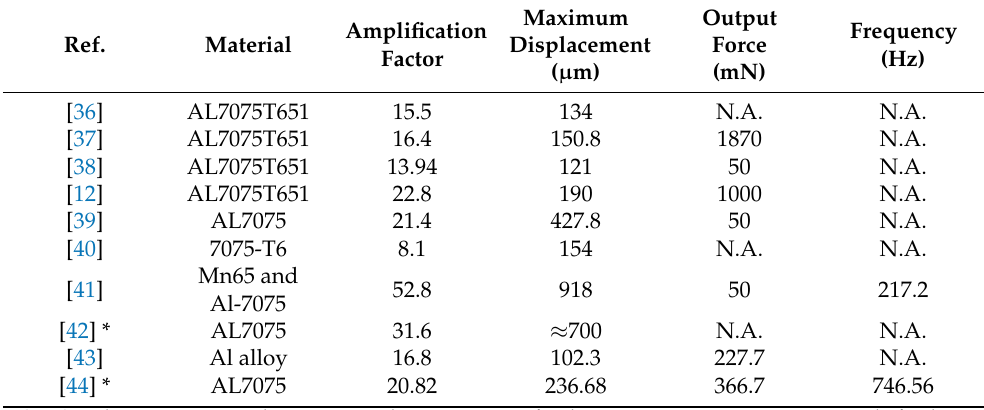
Table 1. Characteristics of microgrippers based on piezoelectric actuation.